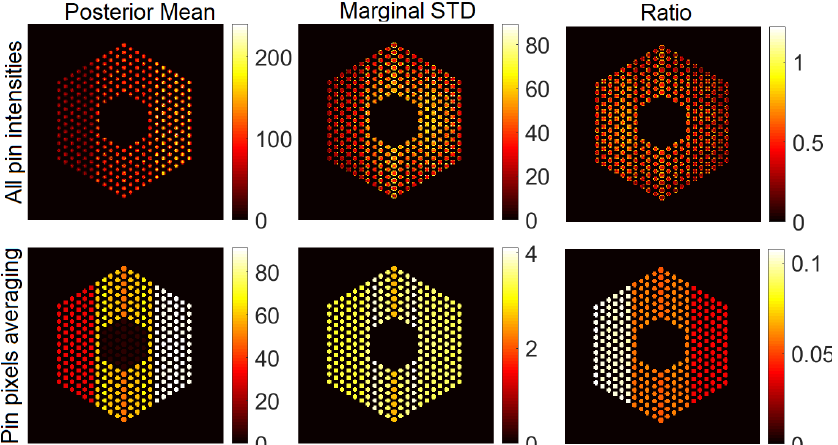
Figure 5. Results of the proposed approach using the Poisson noise model when the peak value is set to 220. Column 1: posterior mean; column 2: marginal standard deviation; and column 3: ratio of marginal standard deviation divided by posterior mean. Row 1: all pixels; row 2: pin pixels averaging.